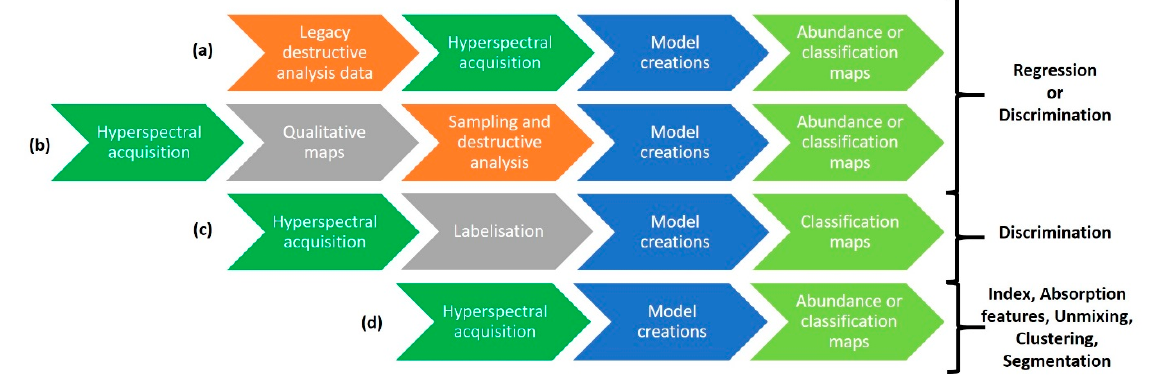
Figure 11. Simplified workflow for creating predictive models with ( a ) legacy data, ( b ) sampling defined by HSI , ( c ) manual and visual labeling, or ( d ) completely blind.